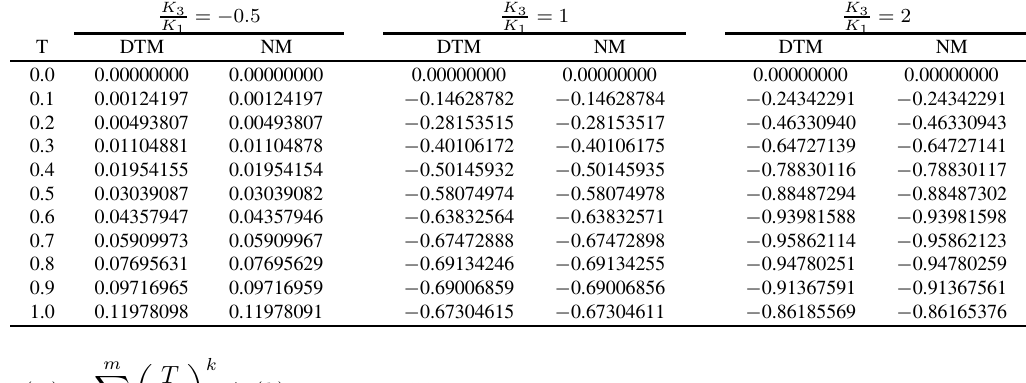
The comparison between the Numerical and DTM solution of X (cid:3) ( T ) for various K 3 K